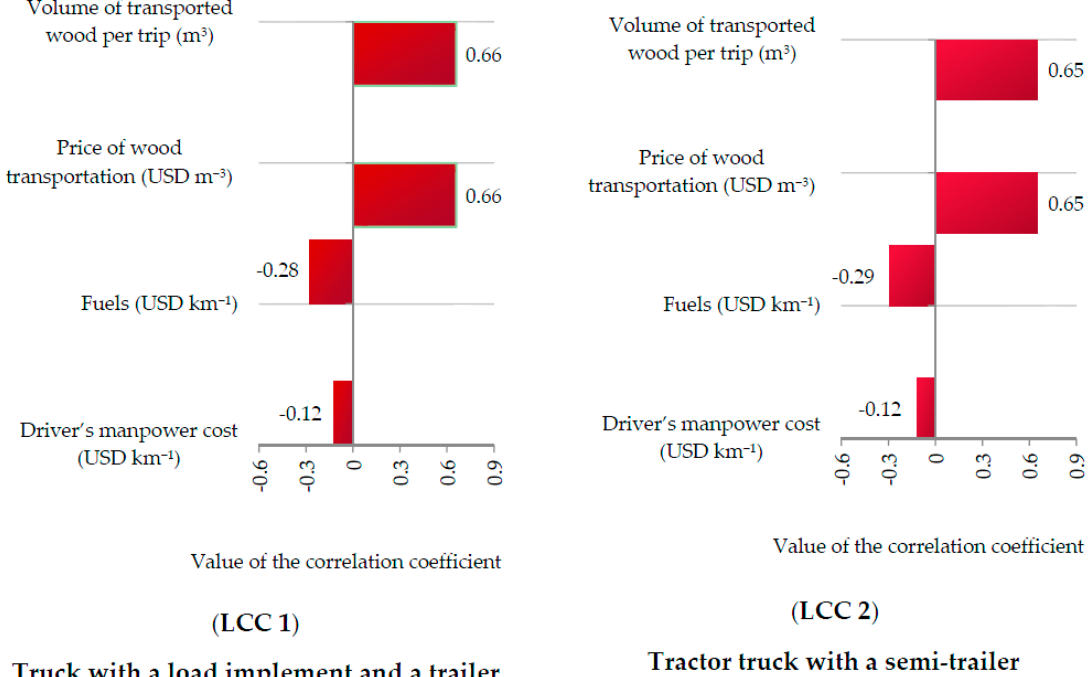
Figure 2. Spearman’s rank-order correlation coefficient of the most critical input variables of the stochastic simulation model in relation to the simulated NPV of financial investment projects of road transportation of wood.